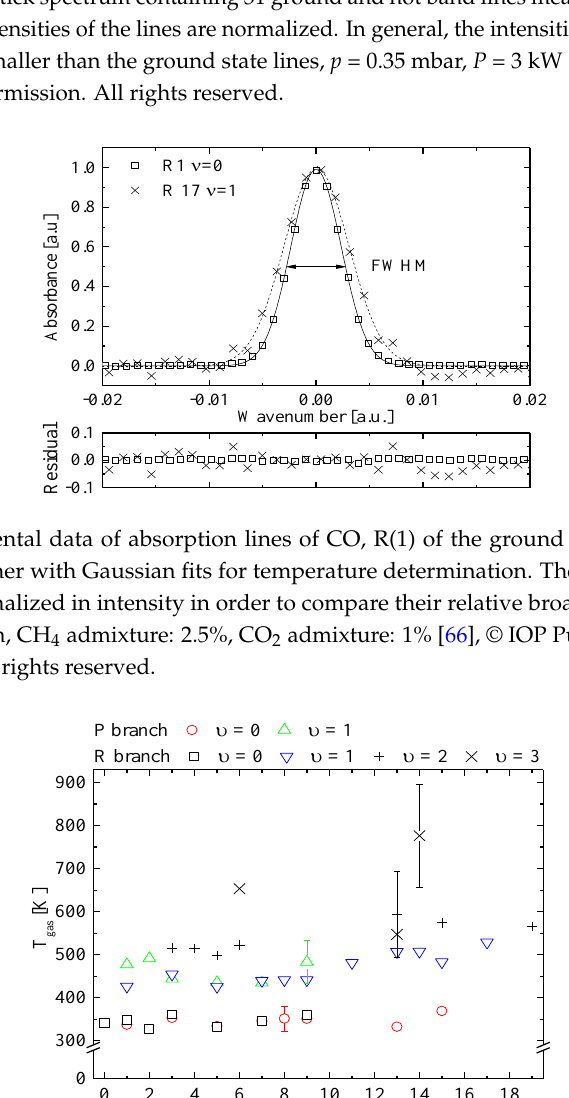
Figure 37. Boltzmann plot of the P and R branch of CO lines of the first hot band for two pressure values, p = 0.25 and 0.35 mbar, P = 3 kW, φ = 50 sccm, CH 4 admixture: 2.5%, CO 2 admixture: 1% [66], © IOP Publishing. Reproduced with permission. All rights reserved. It was found that the rotational temperatures in the various vibrational bands were in very good accordance to the gas temperatures derived from CO Doppler broadening analysis of lines of the ground state and of the first and second hot band of CO. The analysis of the vibrational temperatures clearly showed a non-Boltzmann distribution between the vibrational levels ν = 0 and of ν = 1−3. That ν = 0 has different population characteristics leading to a different vibrational temperature was attributed to the fact that the molecules being measured in this vibrational band were in the outer and therefore colder regions of the plasma. That T vib is not equal to T rot , and that T rot is different for each vibrational level indicates a non-Boltzmann population distribution over the rotational- vibrational states of CO under the present plasma conditions. In conclusion, using the EC-QCL a relatively wide spectral range with a variety of CO lines in the ground and in three excited states has been analyzed. This approach enabled an extensive temperature analysis over several vibrational levels providing new insights into energetic aspects of the multi-component non-equilibrium plasma and indicated that the plasma generation is characterized by a variety of hottest, hot and colder zones in this DAA microwave plasma reactor.